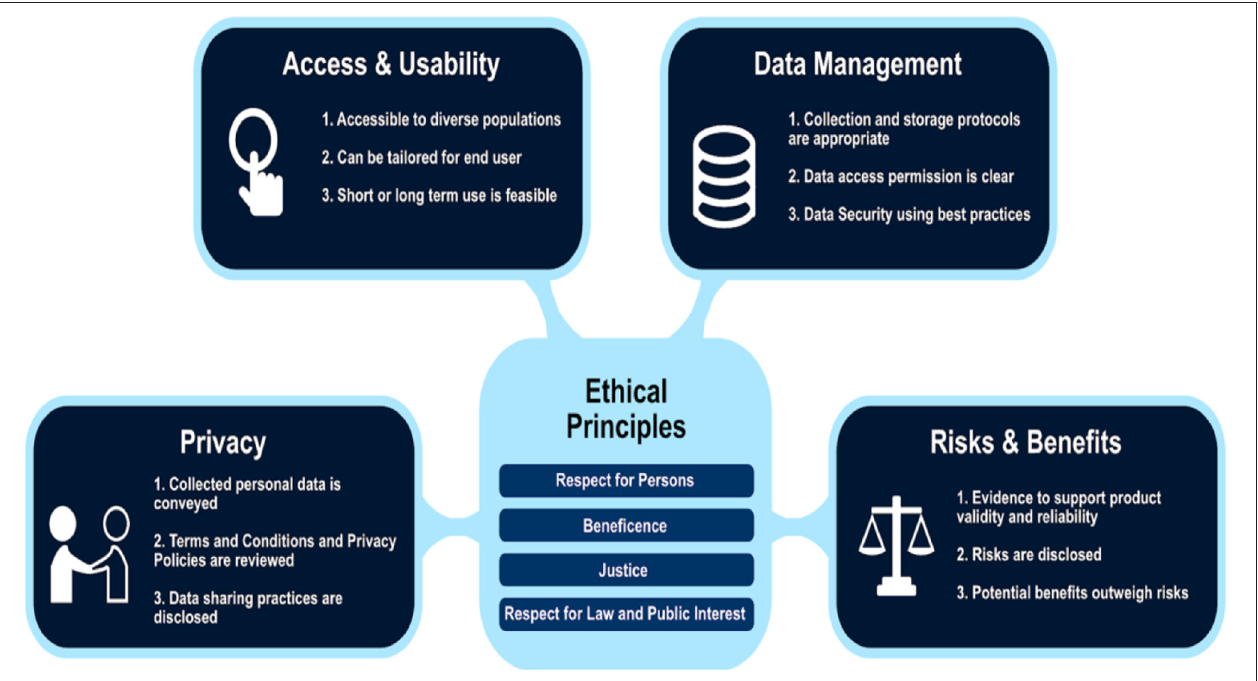
FIGURE 1 | Digital Health Checklist and the four domains connected to foundational ethical principles used with permission. Published with permission of C. Nebeker, ReCODE Health The DHC-R is licensed under a Creative Commons Attribution-Non-Commercial 4.0 International License (2018–2020) and available at https://